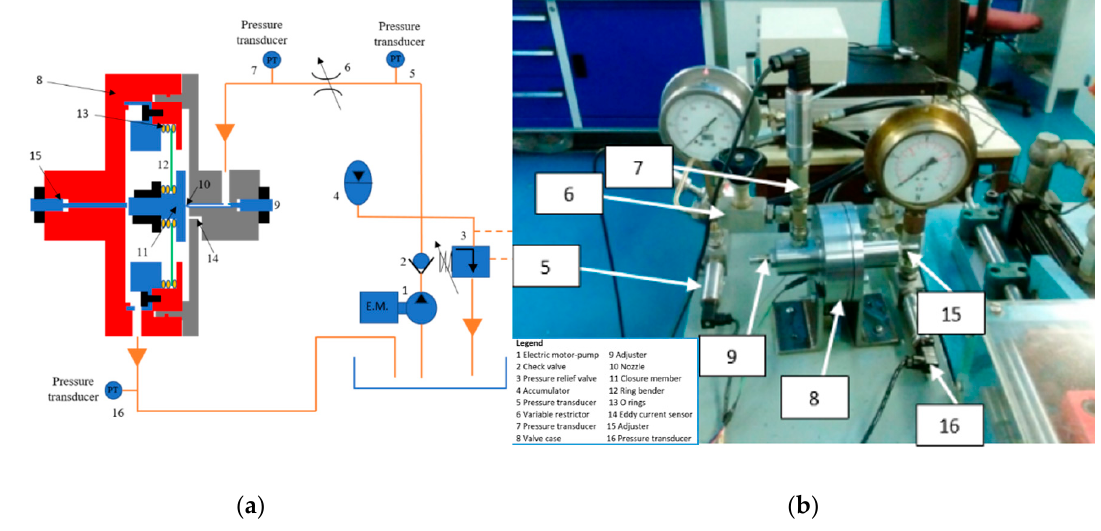
Figure 3. Schematic representation ( a ) and photograph of the test rig ( b ).